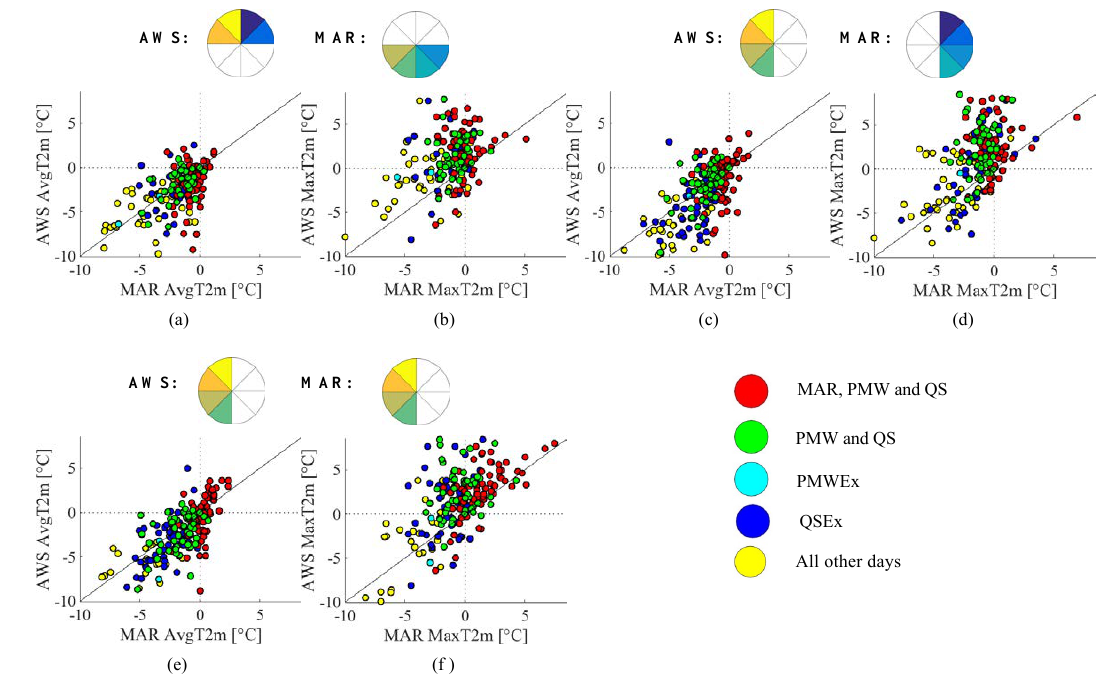
Figure 9. MAR vs. AWS temperatures at the Larsen Ice Shelf AWS station for DJF from 2001–2009 for melt occurrence criteria as shown bottom-right and described in text. Wind direction biases are shown for when northerly AWS flow is reported as southerly in MAR (a) AvgT2m (b) MaxT2m, when westerly AWS flow is reported as easterly in MAR (c) AvgT2m (d) MaxT2 and when AWS and MAR both report westerly flow (e) AvgT2m (f)